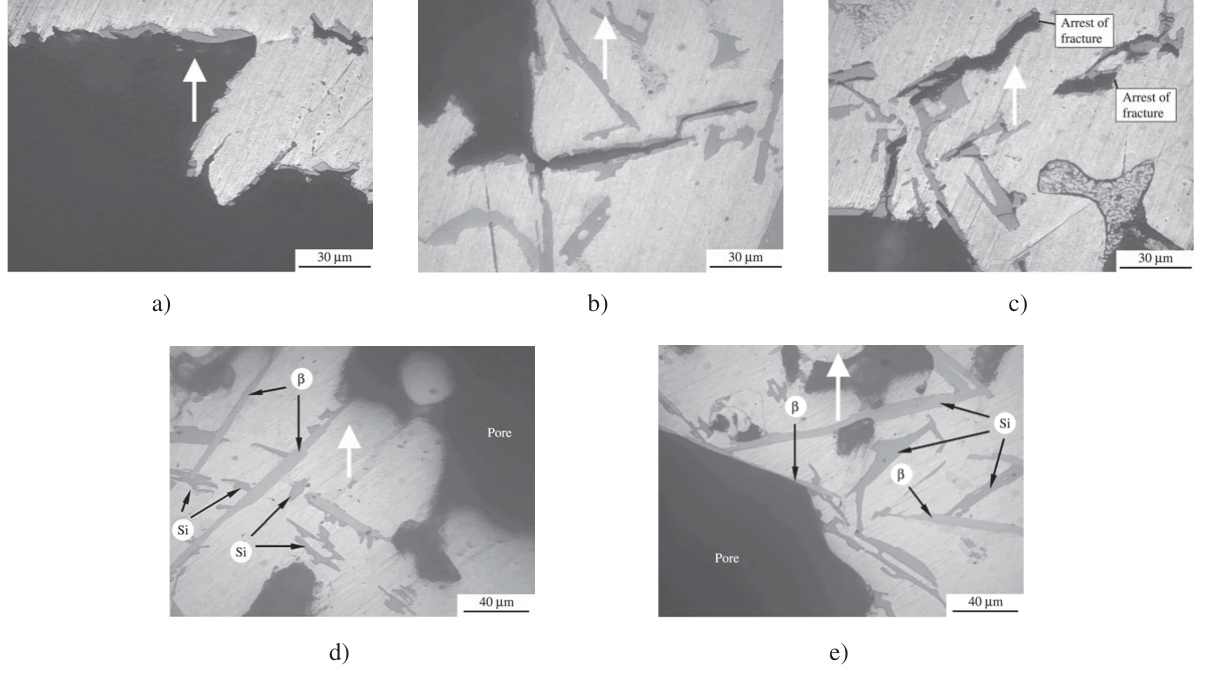
Figure 8. a) e b) Micrograph of the fracture zone showing the form of fracture of Si and β -Al FeSi near the fracture; d) e e) Micrograph of the effect of isolated pores on Si and β -Al particles of Si and β -Al 5